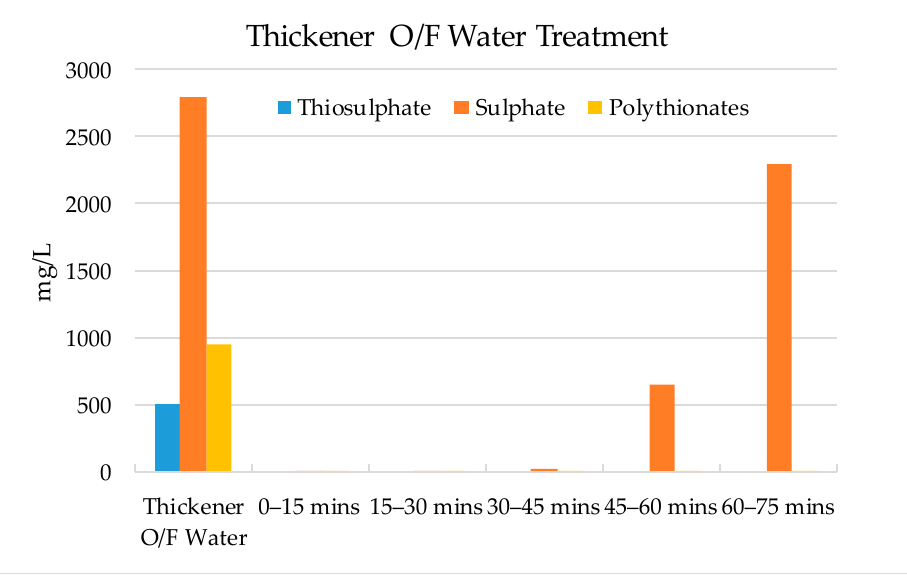
Figure 16. Concentration of residual anions at adsorption stages of Thickener O/F.